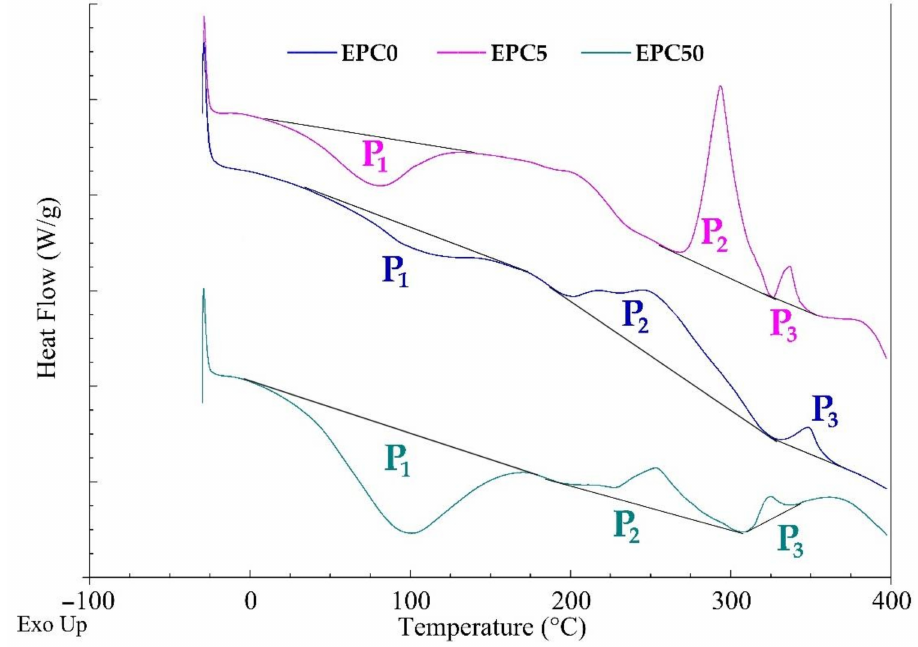
Figure 7. DSC curves of the EPC0, EPC5, and EPC50 foams. EPC0 foam is a polyurethane/polyisocyanurate reference foam used as a